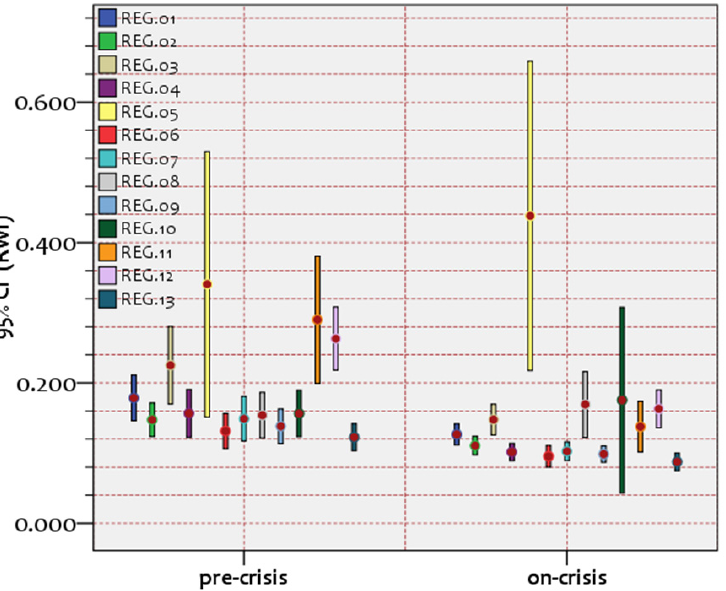
Figure 10. Error bars of 95% CIs of the pre-and on-crisis mean values of the Relative Workers Income (RWI) variable, computed for the 13 (NUTS II) Greek regions (computations across annual data).